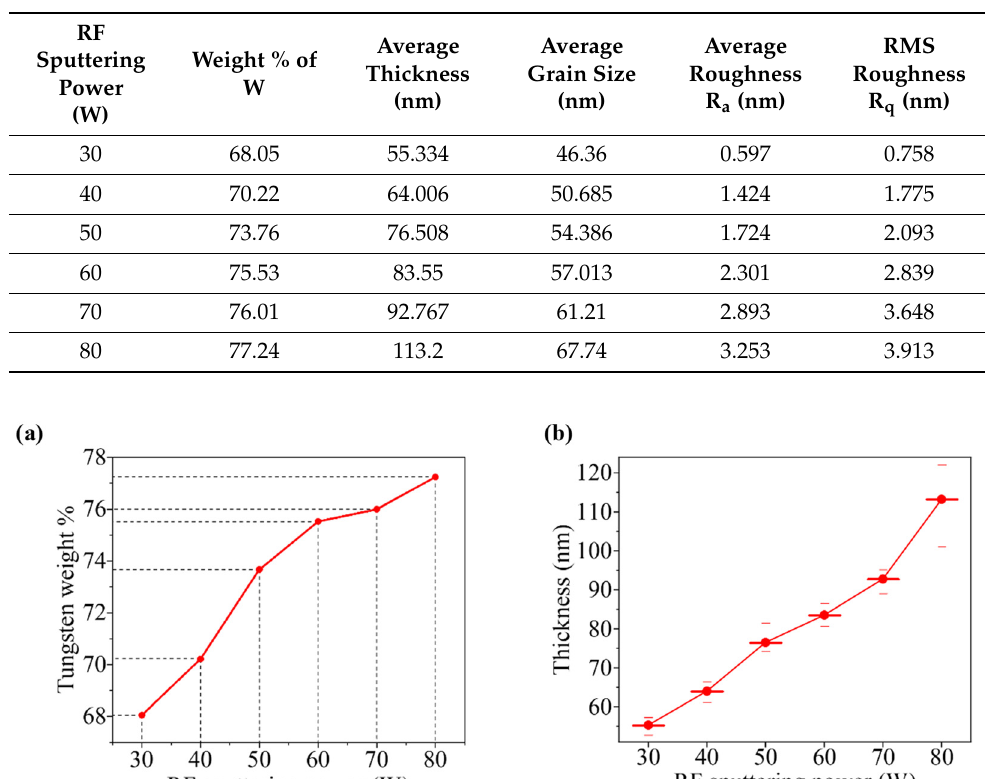
Table 1. Morphological properties of WO x films.